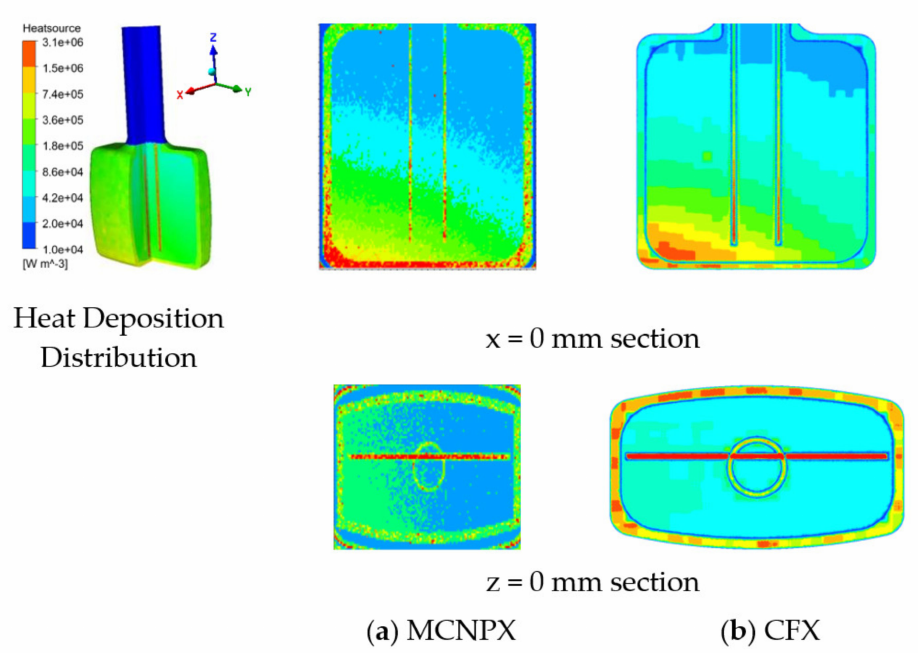
Figure 6. Comparison of heat deposition calculation results between MCNPX and CFX: ( a ) MCNPX; ( b )